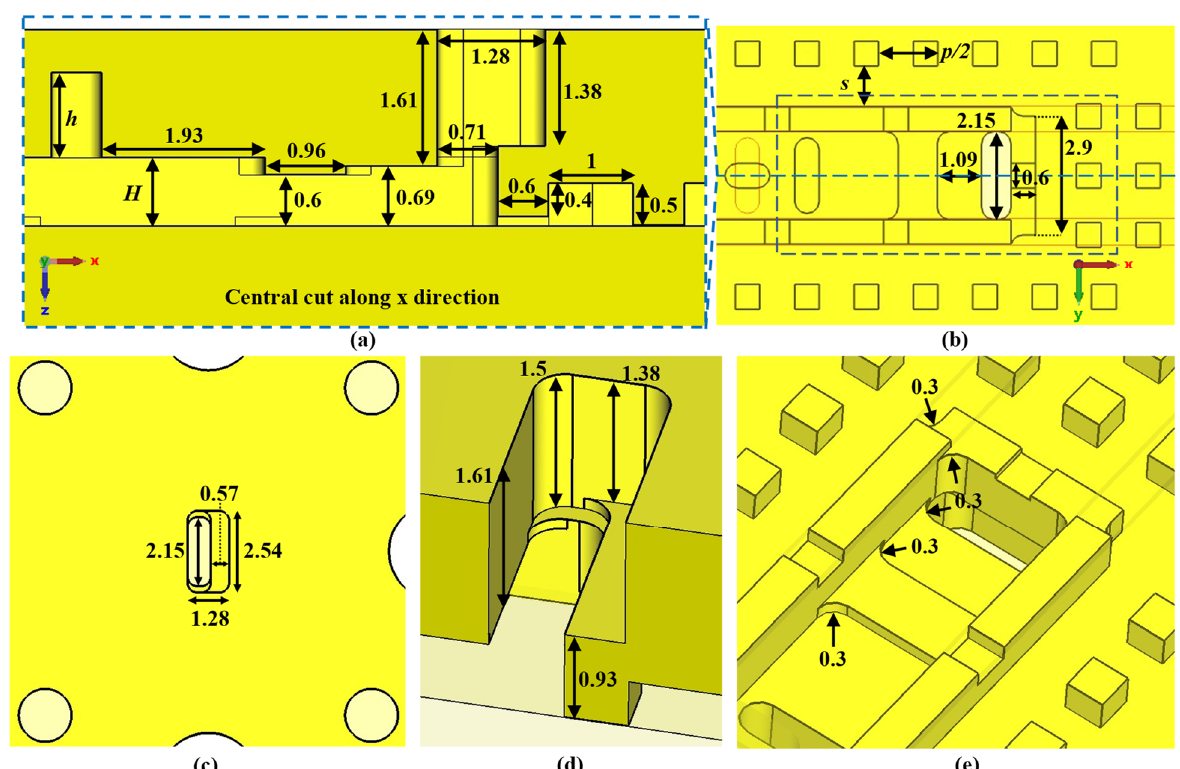
Figure 29. Detailed views of the right-angled bend design to WR-10. ( a ) Lateral cut, ( b ) bottom view, ( c ) top view with the WR-10 input, ( d ) perspective view of the inside of the transition to WR-10 and ( e ) perspective view of the inside.